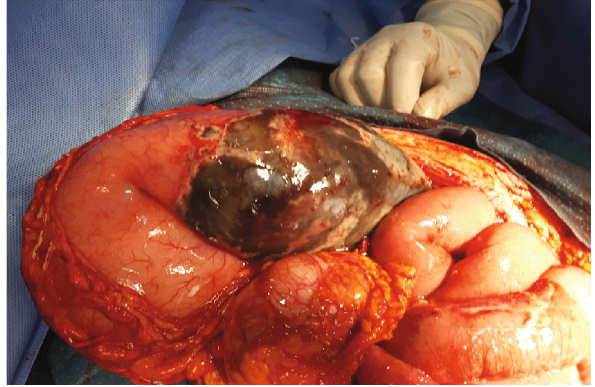
Figure 1: Appearance of the stomach after exposing the posterior